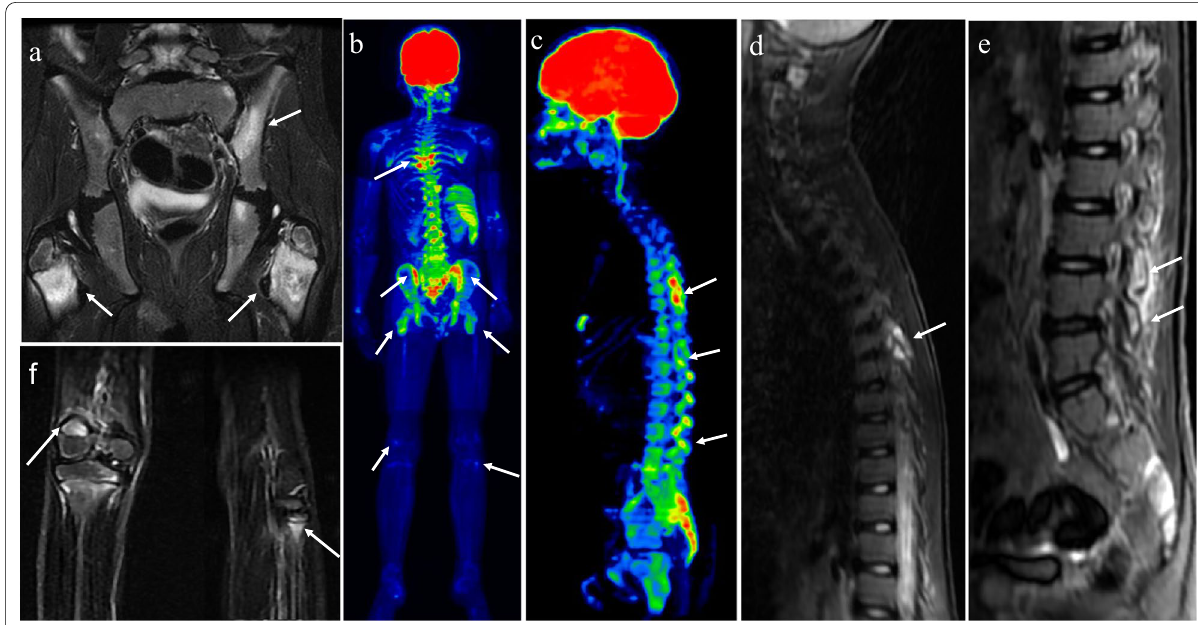
Fig. 4 10-year-old child with CNO and a history of intermittent hip pain since he was 4 years old with elevated markers of inflammation under investigation for juvenile idiopathic arthritis. MRI of the pelvis showed bone marrow edema in the intertrochanteric periphyseal regions and in the sacroiliac joint ( a ), which was suggestive of CNO. WB-MRI was performed on the same day ( b – f ). Functional diffusion-weighted imaging (DWI) sequences ( b and c ) detected multiple lesions in the posterior elements of the thoracolumbar spine, sacroiliac joints and intertrochanteric regions, in addition to the distal metaphysis of the right femur and proximal metaphysis of the left fibula. The lesions are demonstrated in STIR morphological sequences as signal change with an edema pattern in the corresponding locations ( d , e and f ). HLA B27 was